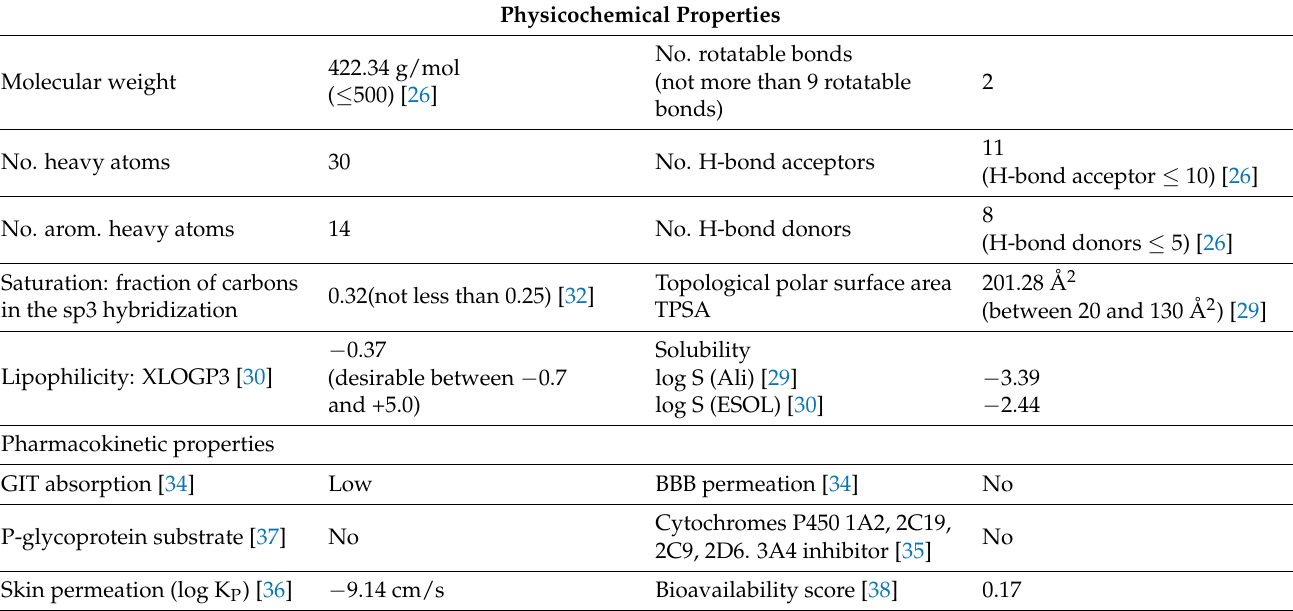
Table 2. Summary of SwissADME predicted physicochemical descriptors and ADMET parameter of the isolated compound.